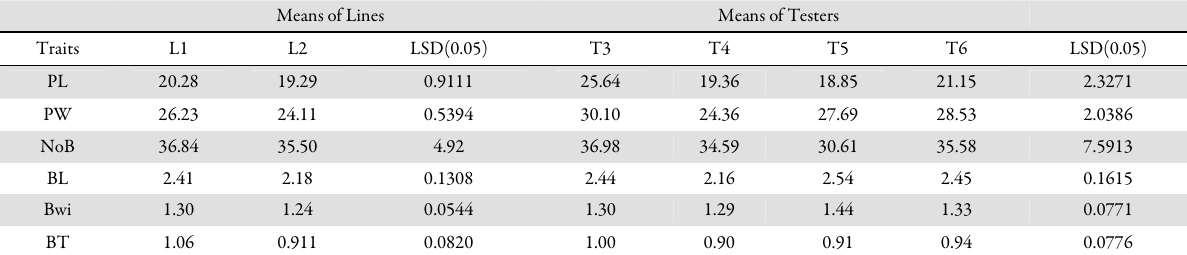
Tab. 2. Descriptive statistics of the two lines and the four testers with respect to the six